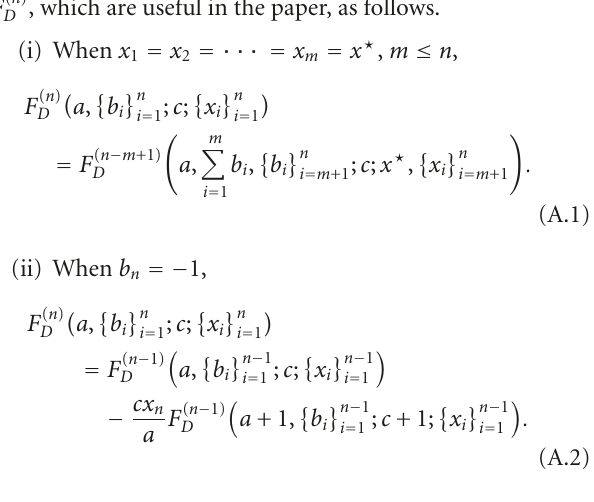
3 bits/s/Hz. From these two figures, we see that the analytical results match exactly with the simulation